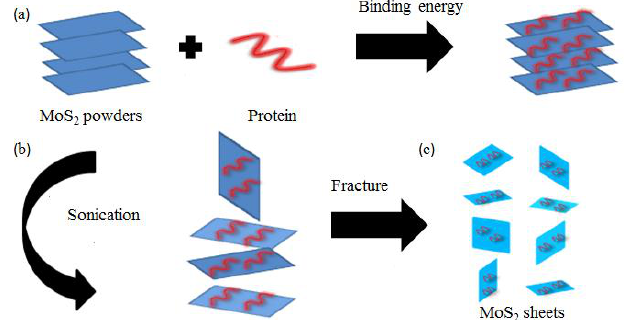
Figure 8. Schematic of protein-induced super-thin MoS 2 flakes. ( a ) Step 1: Protein are strongly adsorbed on MoS 2 surfaces via binding energy. ( b ) Step 2: MoS 2 flakes are exfoliated via ultra-sonication. ( c ) Step 3: Layer-by-layer fracture of MoS 2 flakes takes place gradually. Reproduced with permission from reference Liu et al. [121], Copyright 2016, RSC Advances.